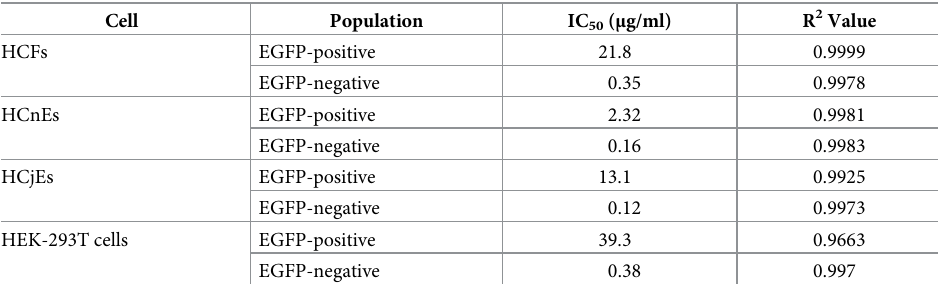
Table 1. IC 50 values for puromycin among the sorted